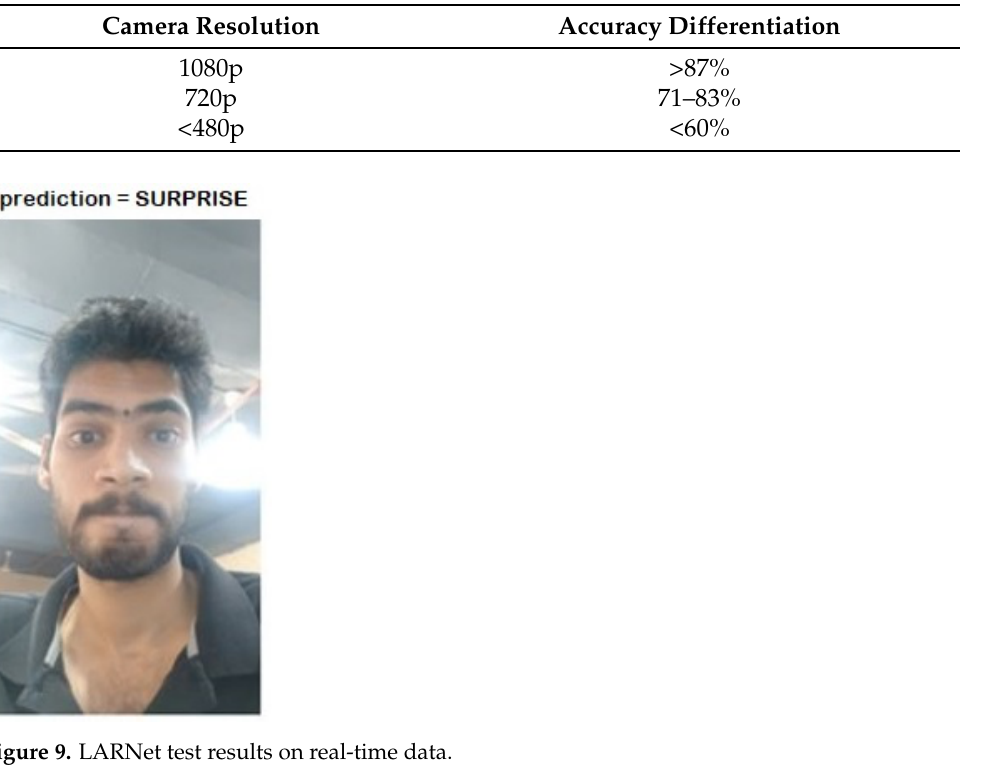
Table 3. Results of real-time data of different camera resolutions for testing evaluation.